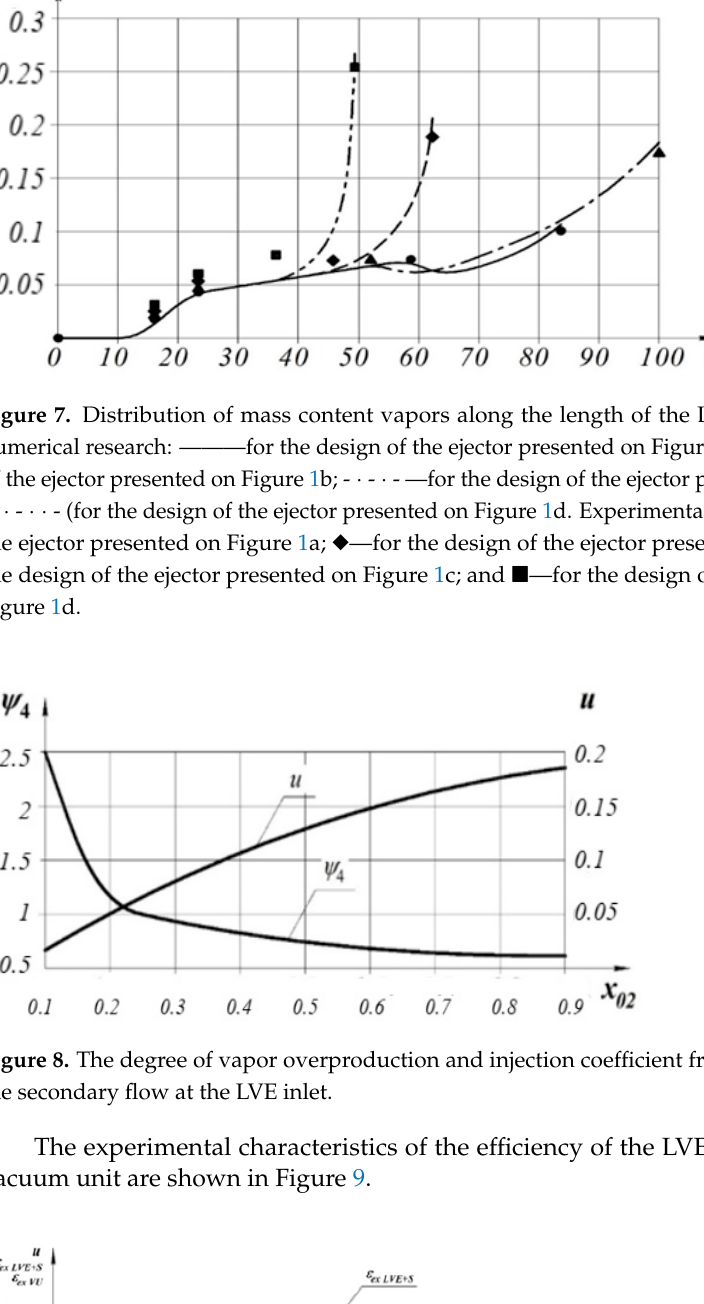
Figure 8. The degree of vapor overproduction and injection coefficient from mass vapor content in the secondary flow at the LVE inlet. the secondary flow at the LVE inlet. the secondary flow at the LVE inlet.